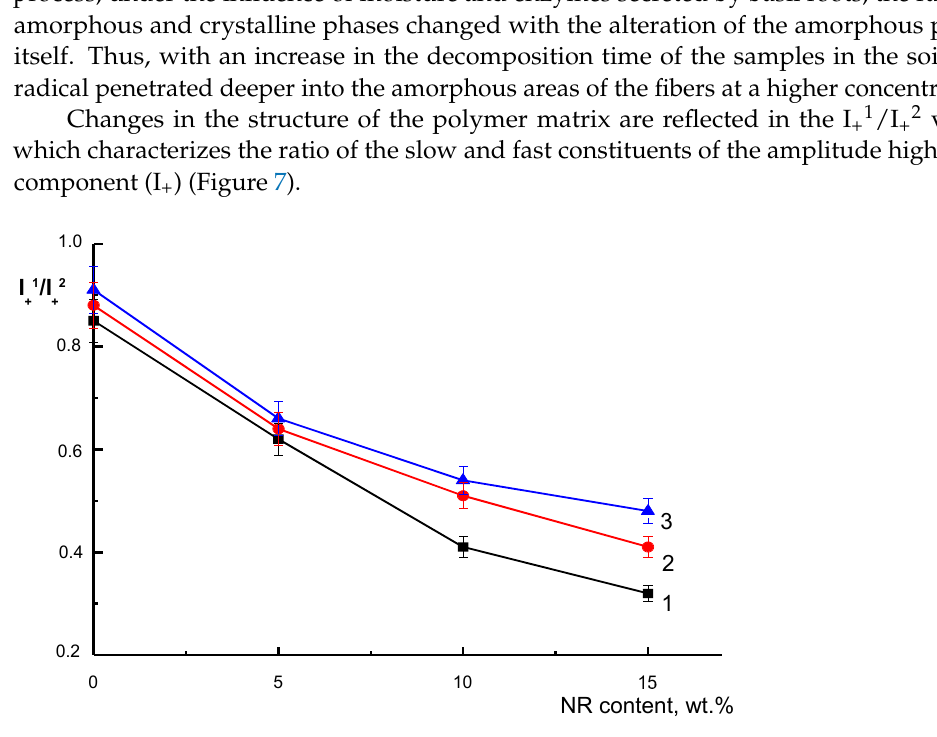
Figure 6. Radical concentration in PLA/NR fibers of initial (1) and after 60 days (2) and 220 (3) of soil exposure.